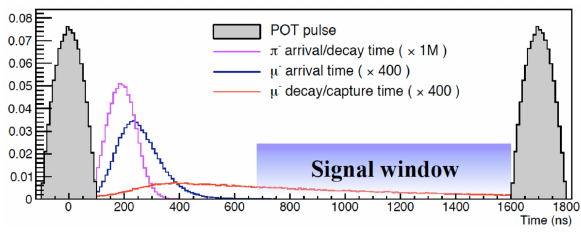
Figure 2. Sketch of the timing structure of the Mu2e